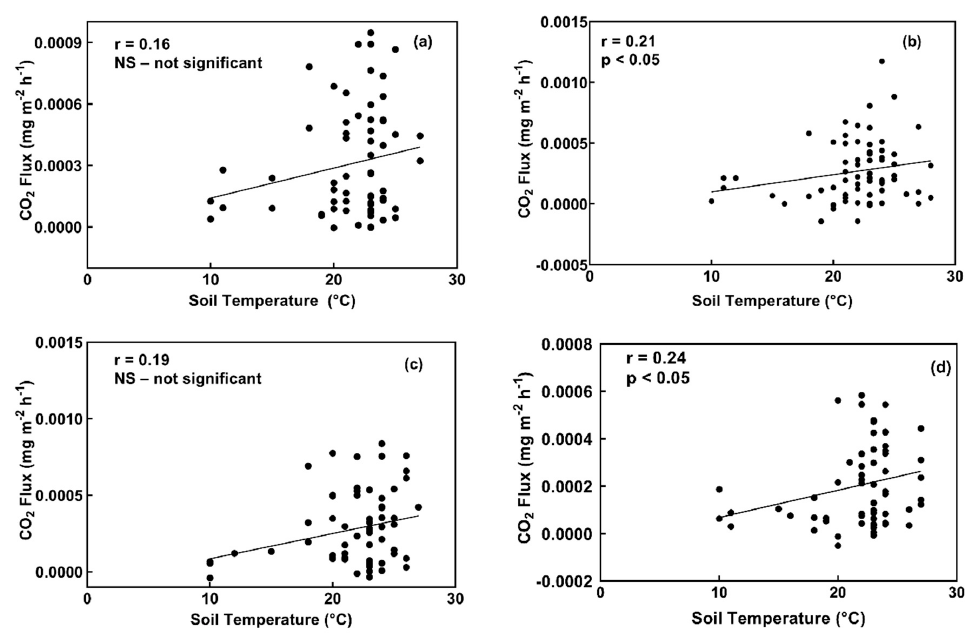
Figure 5. CO 2 fluxes vs. soil temperature at 10 cm in control treatment plots ( a ), and plots treated with urea ( b ), digestate ( c ), and hydrochar ( d ). urea ( b ), digestate ( c ), and hydrochar ( d ). Appl. Sci. 2020 , 10 , x FOR PEER REVIEW